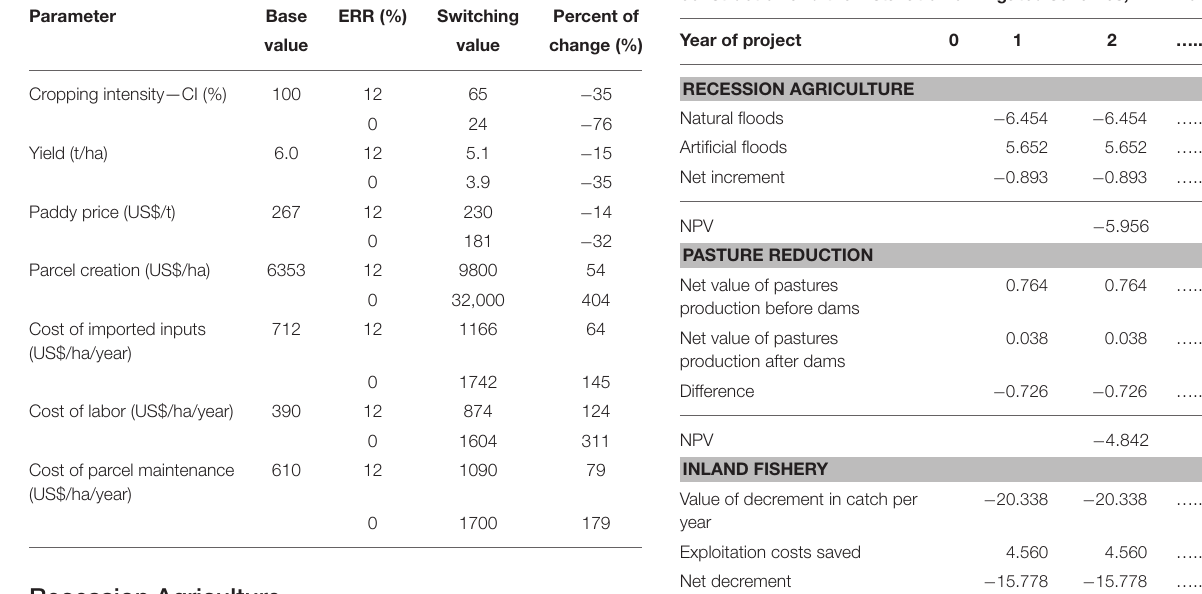
TABLE 6 | Incremental cost-benefit models for S-SRV natural resources productions impacted by changes in the S-SRV after the dams construction and the installation of irrigated schemes, in million